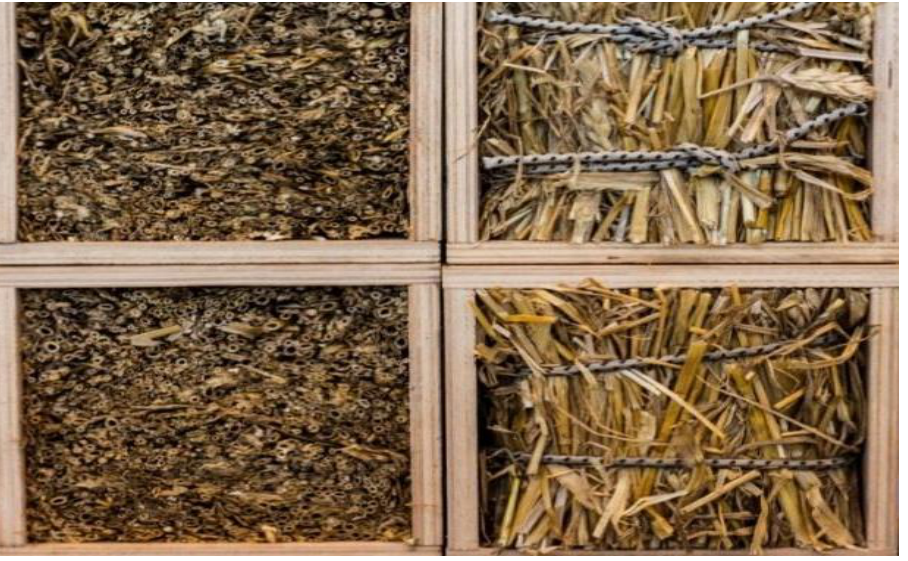
Figure 2. Straw compressed in frames to a value corresponding with its compression during